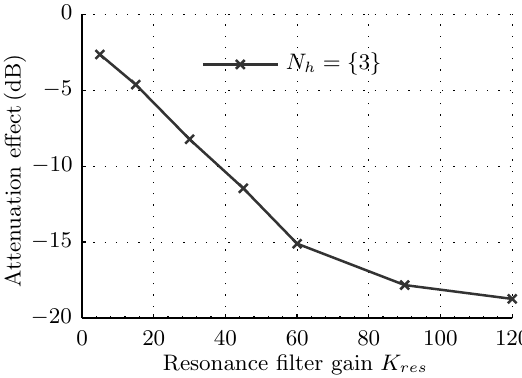
Figure 15. Experimental results. The local voltage 3 rd harmonic attenuation as a function of the resonance filter gain K res , ˆ f g = 49.9Hz, f g = 50Hz and N h = { 3 }